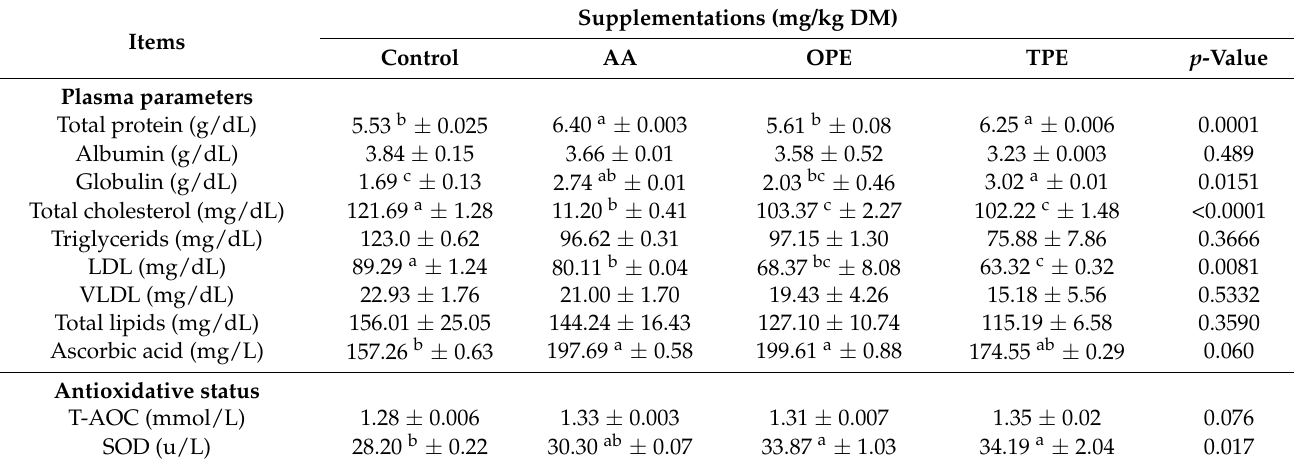
Table 6. Effect of dietary supplementation of AA, OPE and TPE on plasma parameters and antioxidative status of the growing